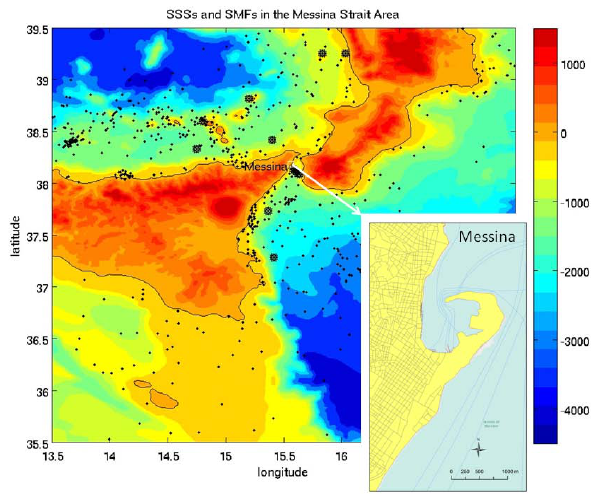
Fig. 2. The Messina Strait Area. Submarine Seismic Sources (SSSs) are the black dots and Submarine Mass Fail- ures (SMFs) are the black stars. The map of the city of Messina with the all ISTAT sections is shown in the lower